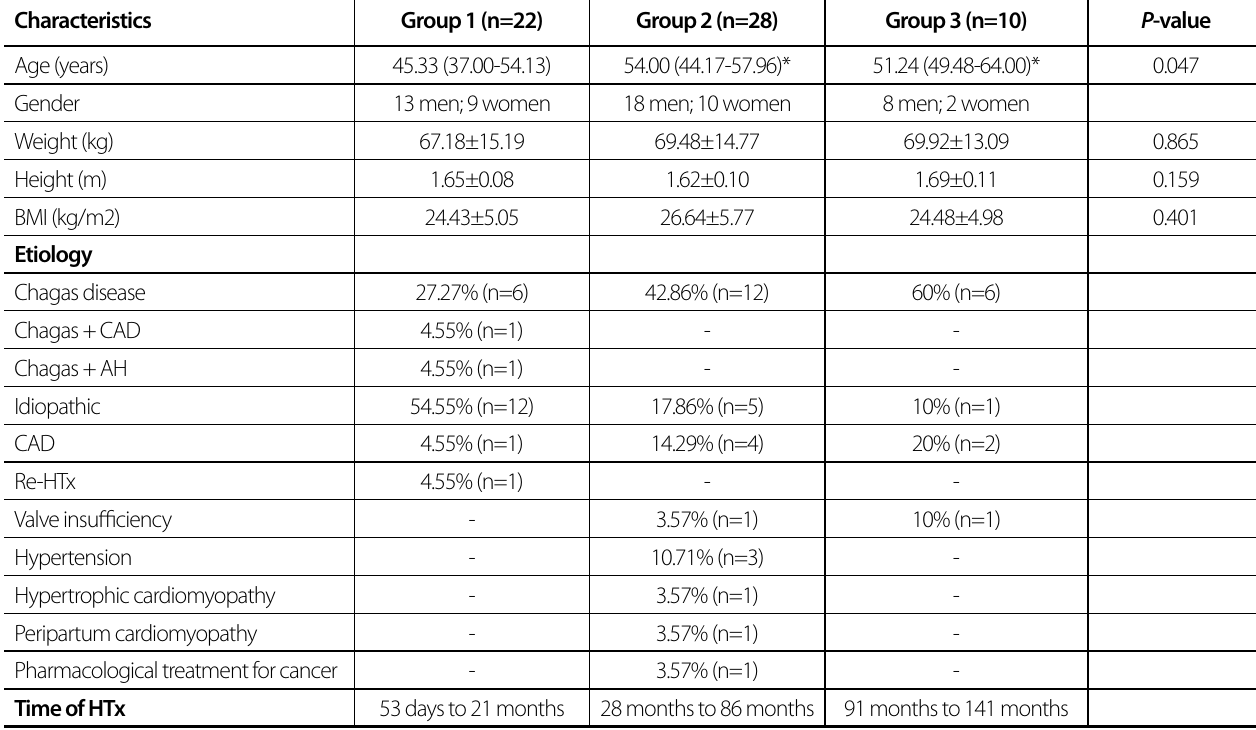
Table 1 . Patients’ age, gender, anthropometric characteristics, etiology of heart failure prior to cardiac transplant and time of HTx. Characteristics